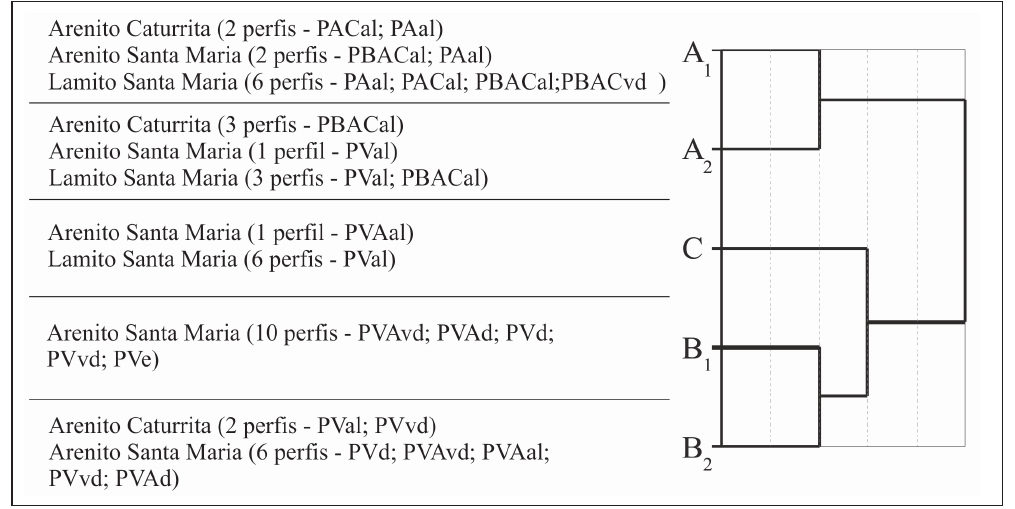
figura 2. solução de agrupamentos dos perfis de argissolos derivados de materiais sedimentares da depressão central do rio grande do